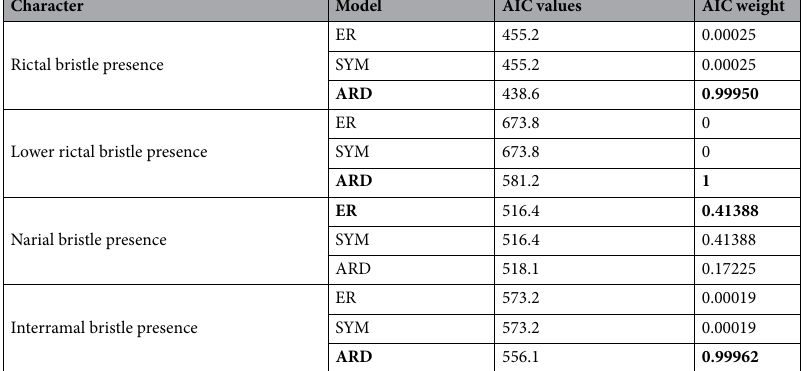
Table 1. Comparison between the different transition rate models using AIC (Akaike Information Criterion) values and weight: equal-rates (ER), symmetrical (SYM) and all-rates-different (ARD) models for categorical data and Brownian motion (BM), Ornstein–Uhlenbeck (OU) and Early-burst (EB) models for continuous data. Values in bold illustrate the best fit model selected for the